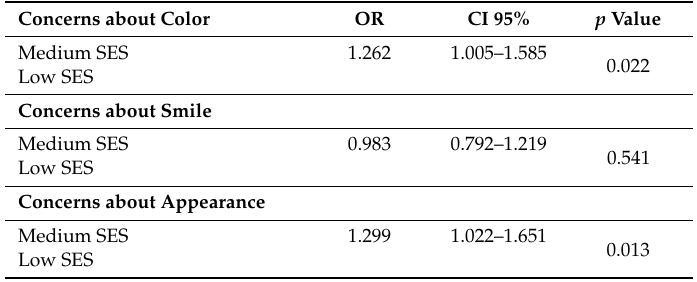
Table 1. Bivariate analysis between self-perception and different socioeconomic levels in the TF 2–3 population.